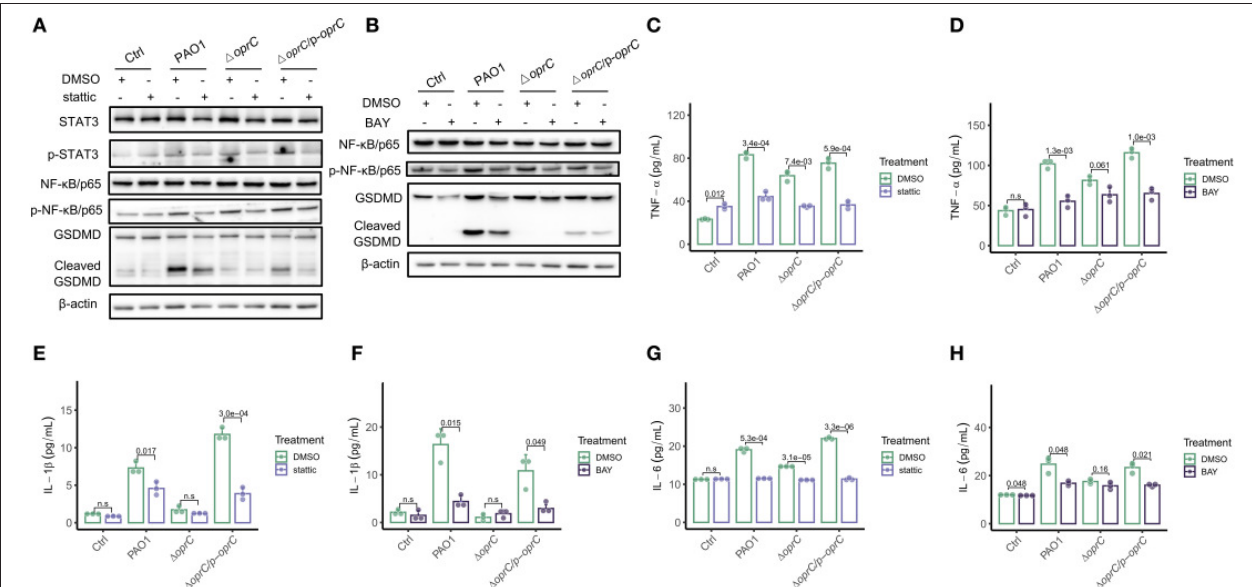
FIGURE 6 | STAT3/NF- κ B inhibitors decreased pyroptosis following P. aeruginosa infection. MH-S cells pretreated with 10 µ m stattic (the inhibitor of Stat3 activation) for 30min, or BAY (the inhibitor of NF kappa B activation) for 1h, were challenged with bacteria at a multiplicity of infection (MOI) of 10 for 2h. Cell lysis and supernatants were used for western blot and ELISA analysis, respectively. (A,B) Western blot analysis of STAT3, p-STAT3, NF- κ B/p65, p-NF- κ B/p65, and GSDMD. (C–H) TNF- α , IL-1 β , and IL-6 were assessed by ELISA ( n = 3). Error bars represent the mean ± s.d. One-way ANOVA with a post-hoc Tukey test was performed for comparison of means of